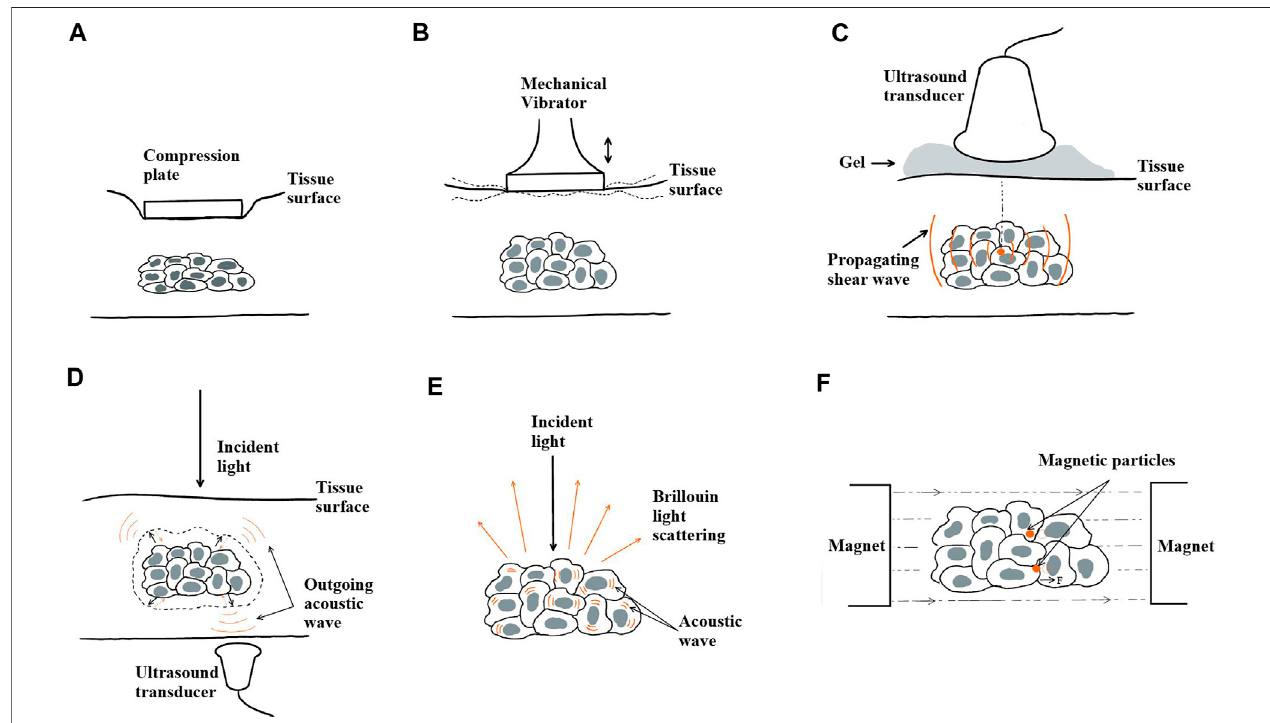
FIGURE 5 | Actuation principles ofelastography techniques. (A) Quasi-staticmechanical actuation, (B) dynamic mechanical actuation, (C) acoustic actuation, (D) optical actuation with photoacoustic effect, (E) optical actuation with Brillouin light scattering, and (F) magnetic actuation.